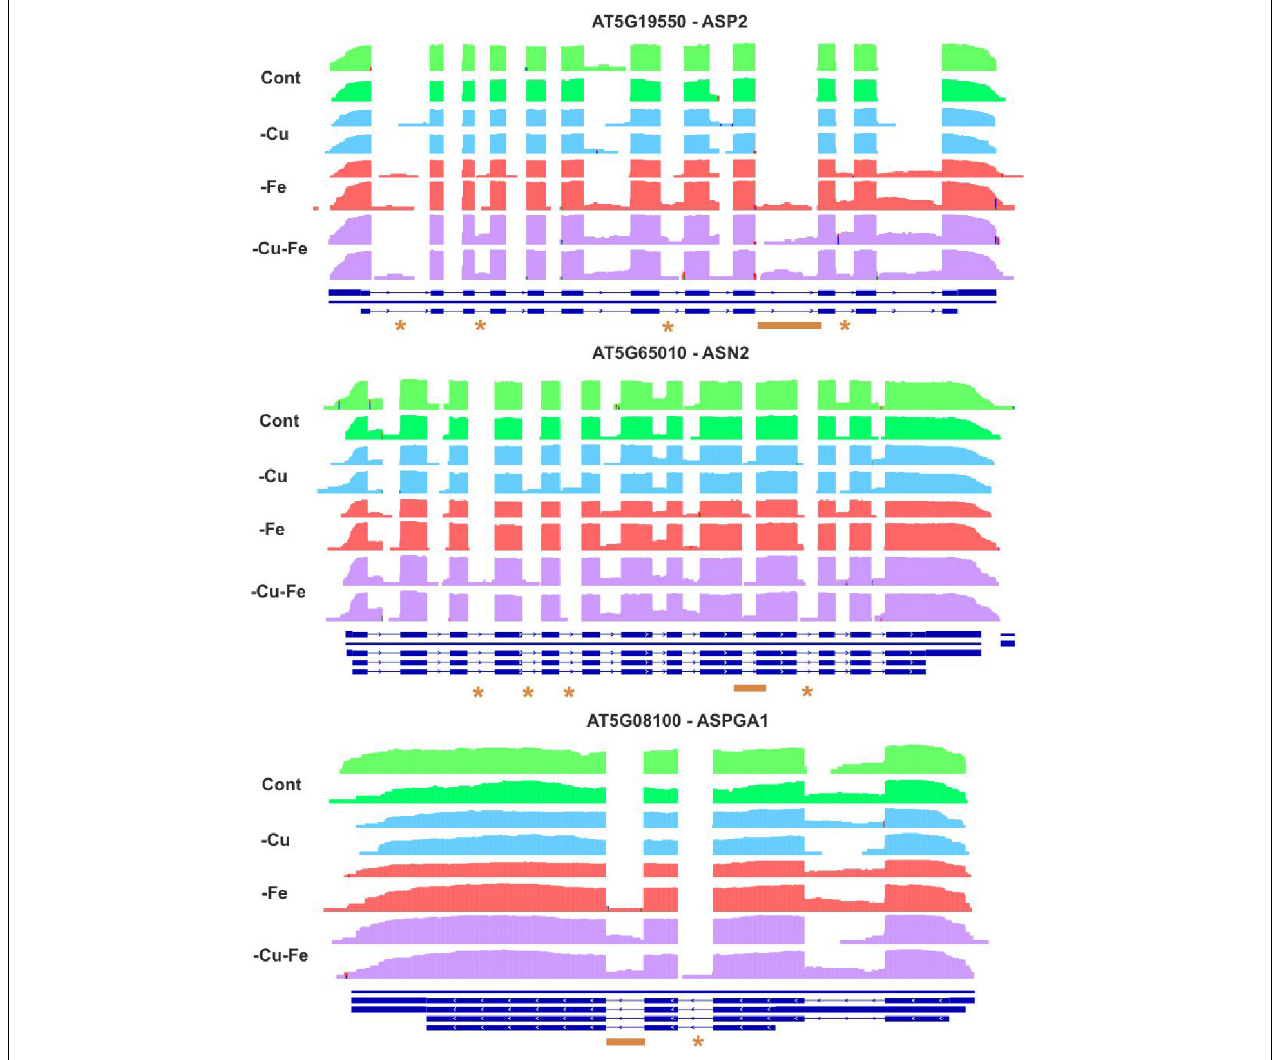
FIGURE 6 | Visualization of alternative splicing events in the transcripts involved in asparagine biosynthesis under single and simultaneous copper and iron deficiency. Log 10 -transformed read counts were used to represent the RNA-Seq coverage of intronic and exonic regions of ASPARTATE AMINOTRANSFERASE 2 (ASP2), ASPARAGINE SYNTHETASE 2 (ASN2), and L -ASPARAGINASE (ASPGA1) under standard conditions (Cont) and single and double copper and iron deficiencies (–Cu, –Fe, and –Cu–Fe). Differences in the presence of intronic regions are depicted as asterisks (for changes in one replicate under –Fe or –Cu–Fe) or as orange lines (changes exclusive to –Cu–Fe conditions). Blue lines represent the gene model in